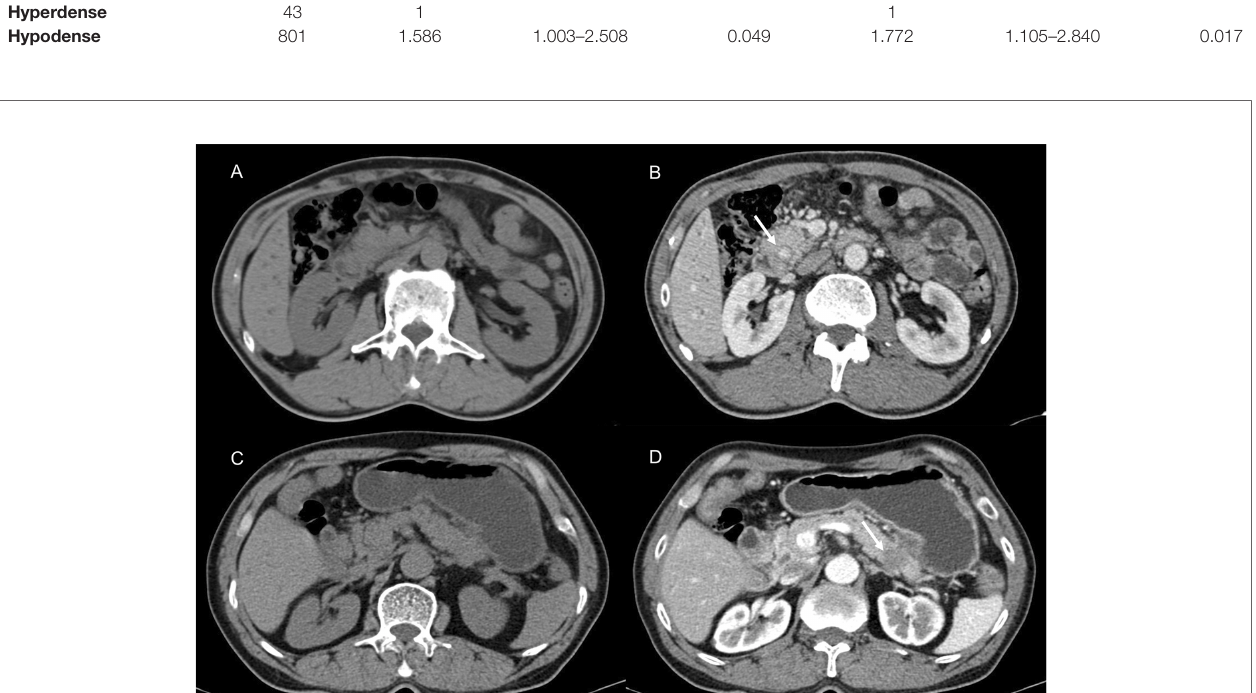
FIGURE 3 | Presentive CECT images of PDAC. (A, B) CECT revealed a lesion in the head of the pancreas. The tumor [ (B) , white arrow] showed higher density in the parenchymal phase. (C, D) Typically, hypodense PDAC tumors present in the tail of the pancreas [ (D) , white arrow].